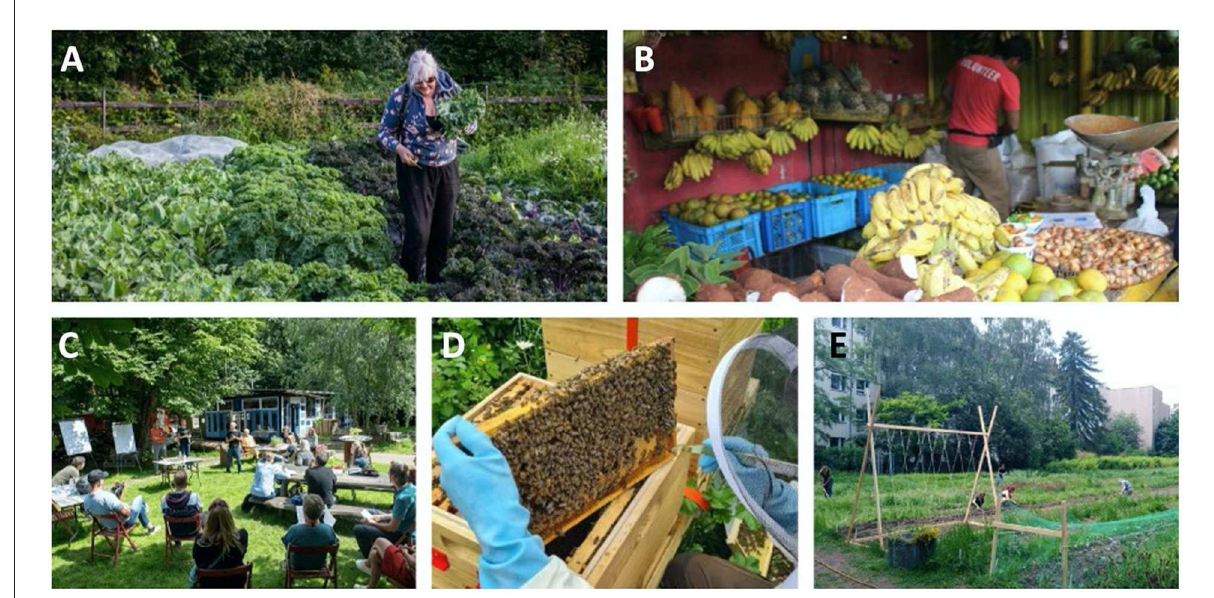
FIGURE2 Images from the EdiCitNet Living Labs in Oslo (A) , Havana (B) , Rotterdam (C) , Andernach (D) , and Berlin (E) . Source: